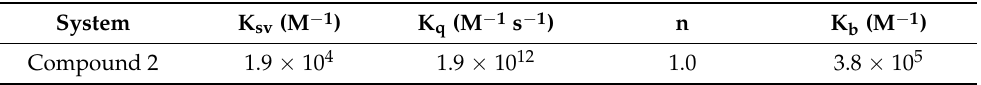
Table 4. From fluorescence measurements, values of Stern–Vomer, bimolecular enhancement constant, binding site number and binding constant achieved.